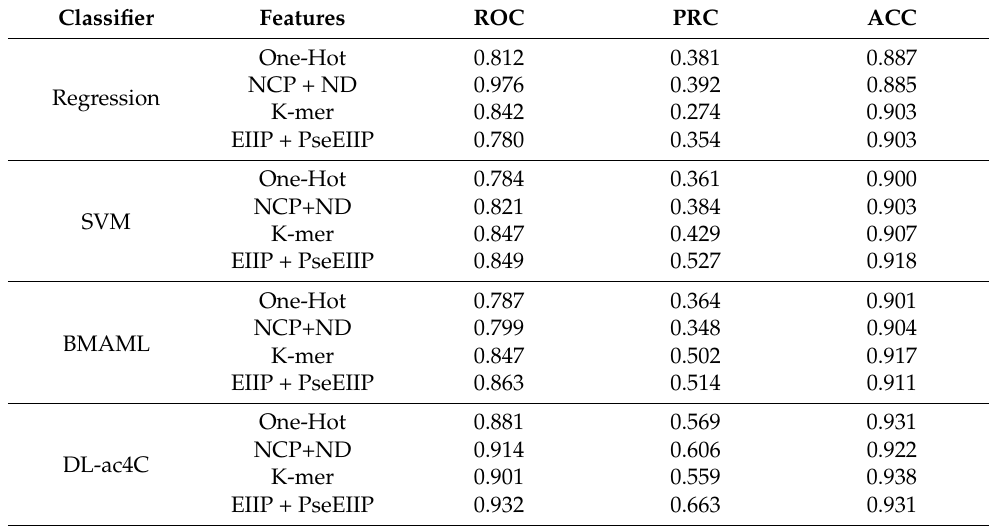
Table 2. DL-ac4C and comparison with existing